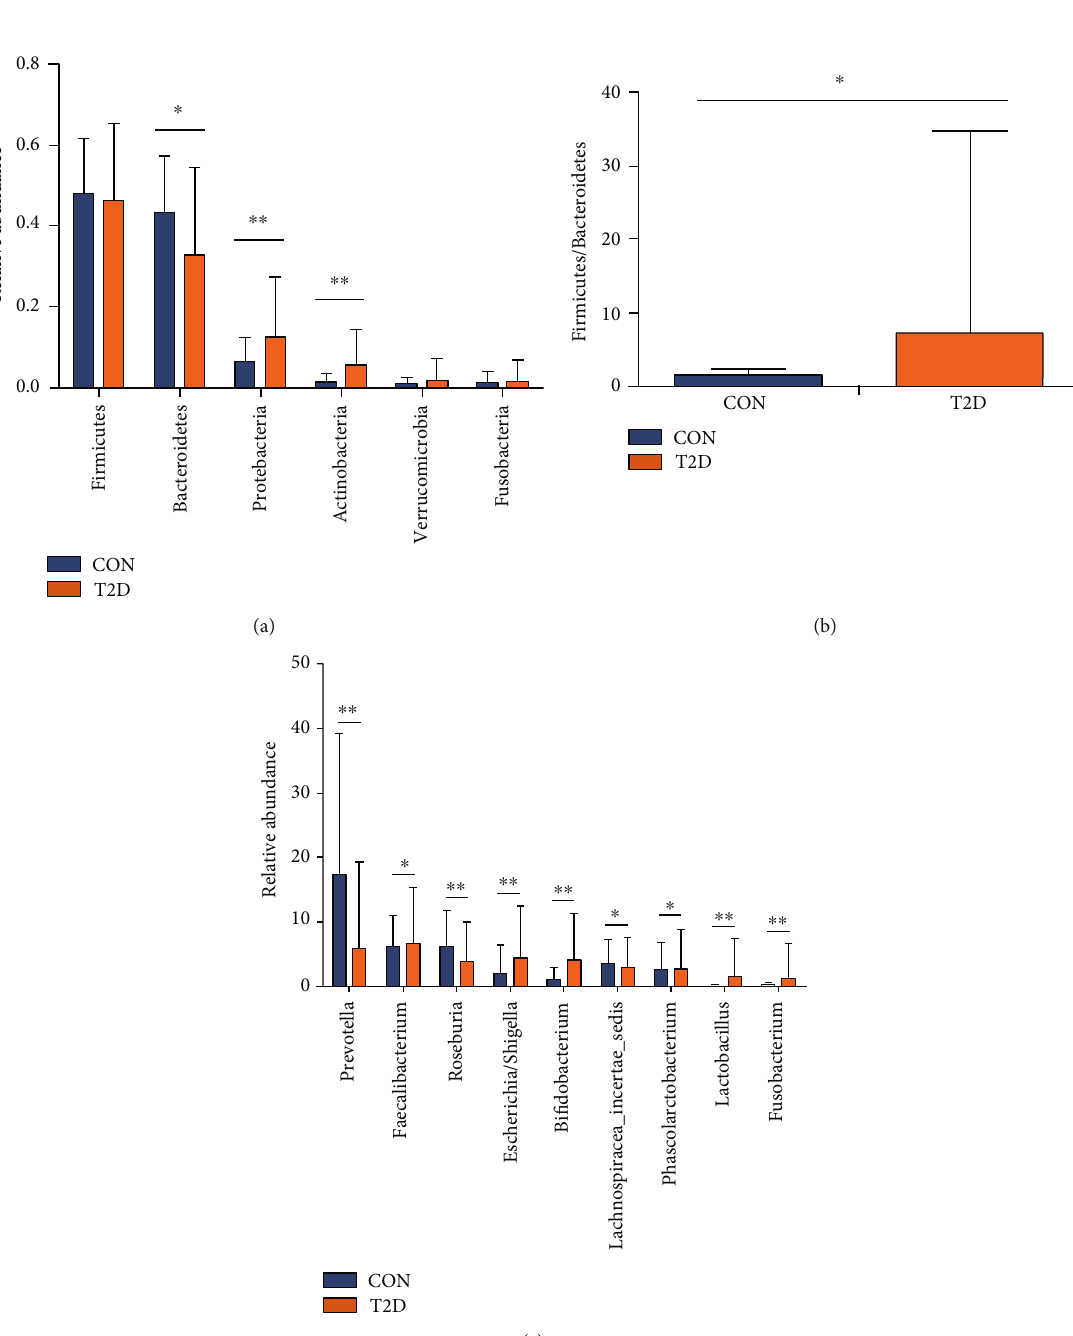
Figure 2: Relative abundances of fecal taxa at di ff erent levels. (a) For di ff erences in the fecal microbiota at the phylum level. (b) The F/B ratio in two groups. (c) For di ff erences in the fecal microbiota at the genera level. Statistical analysis was performed by Mann – Whitney U test. ∗ P < 0 : 05 , ∗∗ P < 0 : 01 . CON: nondiabetic control group; T2D: type 2 diabetes